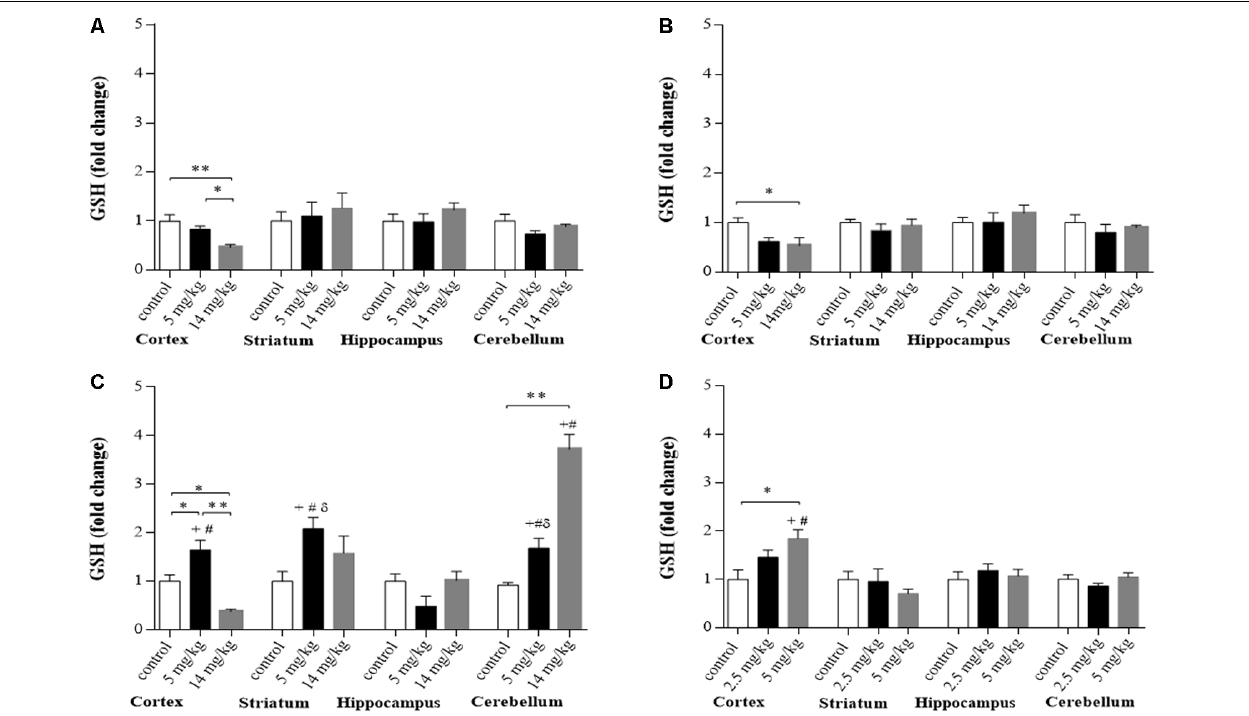
FIGURE 1 | Glutathione (GSH) levels in different brain regions of mice treated i.p. with 0 (controls), 2.5, 5, or 14 mg/kg NaAsO 2 . Normalized levels of GSH ratios in animals treated with 5 and 14 mg/kg at 2 h (A) , 6 h (B) , and 24 h (C) and animals treated with 0, 2.5, or 5 mg/kg for 9 days (D) . Data in graphs represent the mean ± SE, n = 6. The data were analyzed using one and two-way analysis of variance (ANOVA) with Tukey’s post hoc analysis. Different superscript symbols above each column indicate statistically significant differences; ∗ P ≤ 0.05 and ∗∗ P ≤ 0.01 for dose-related differences; plus symbol denotes differences from the 2 h group, number symbol denotes differences from the 6 h and delta symbol denotes differences from 9-day treatment. Significance was accepted at P ≤ 0.05. Significance was accepted at P ≤